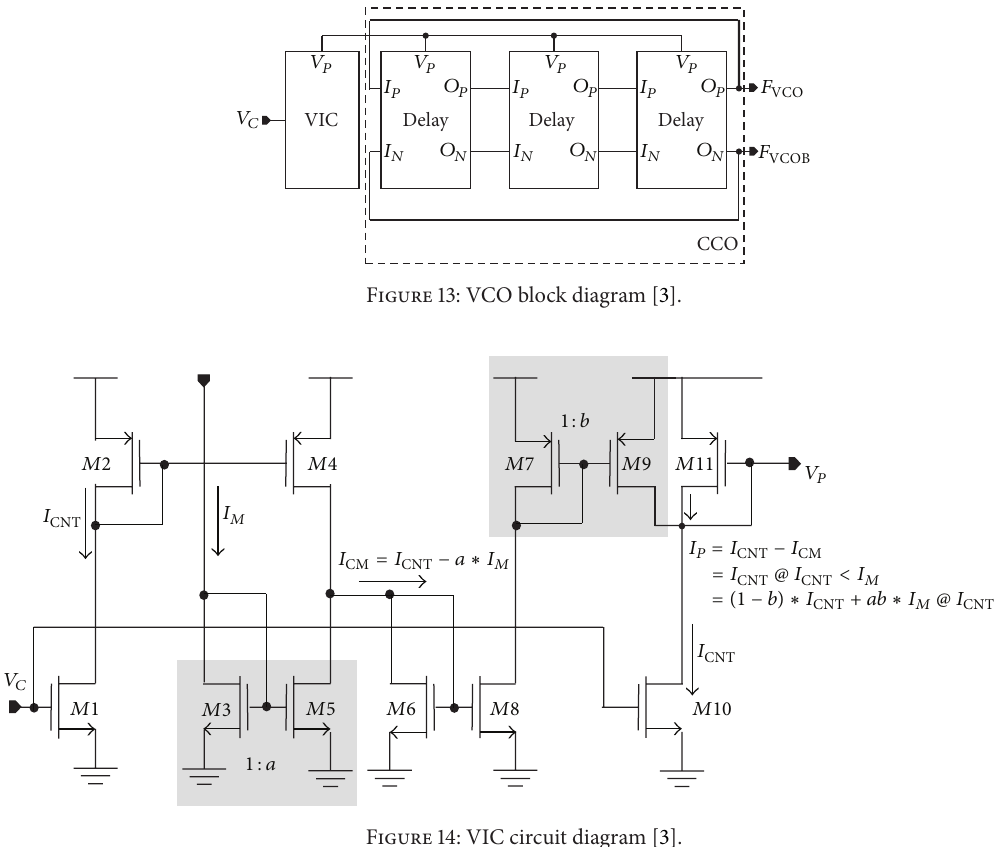
Figure 14: VIC circuit diagram [3].